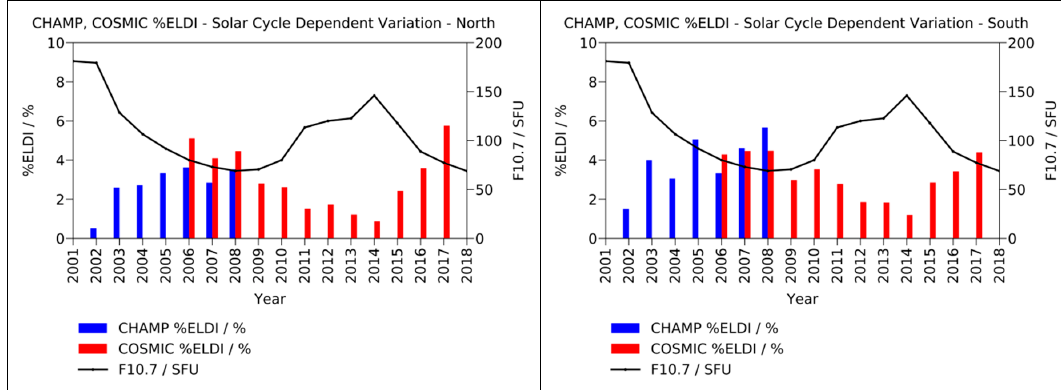
Figure 8. Solar cycle dependent variation of %ELDI for COSMIC and CHAMP for 2001 to 2018. ( Left panel ) northern high latitude region; ( right panel ) southern high latitude region.